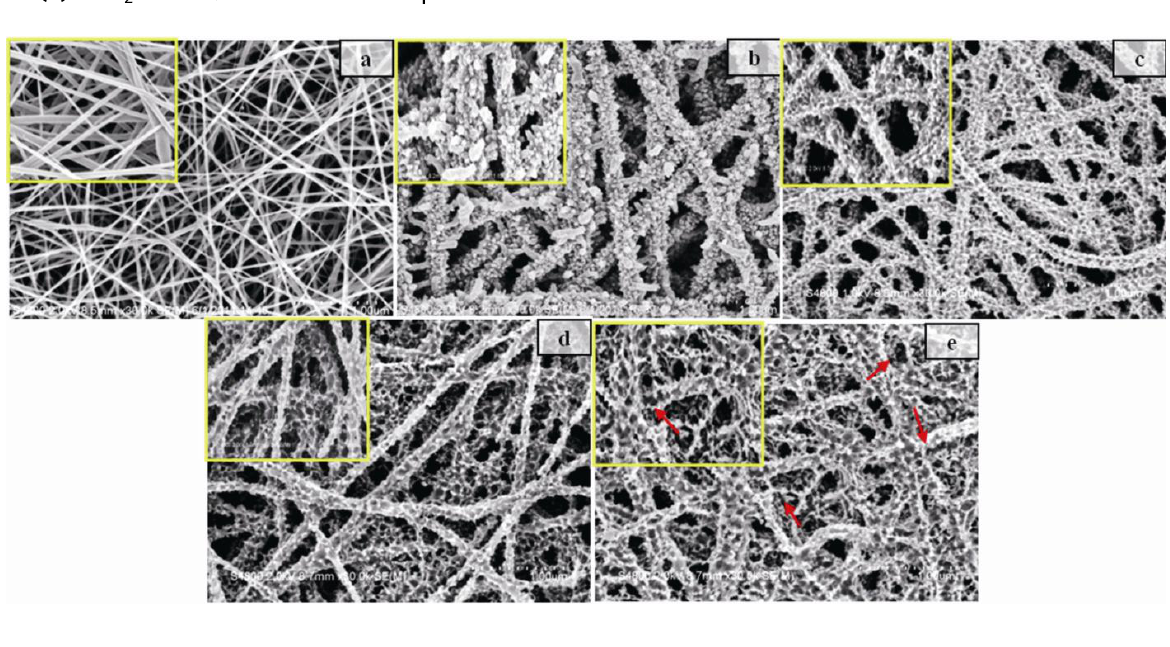
-PANI/PA6 nanofibers sputtered for 60 min, 2